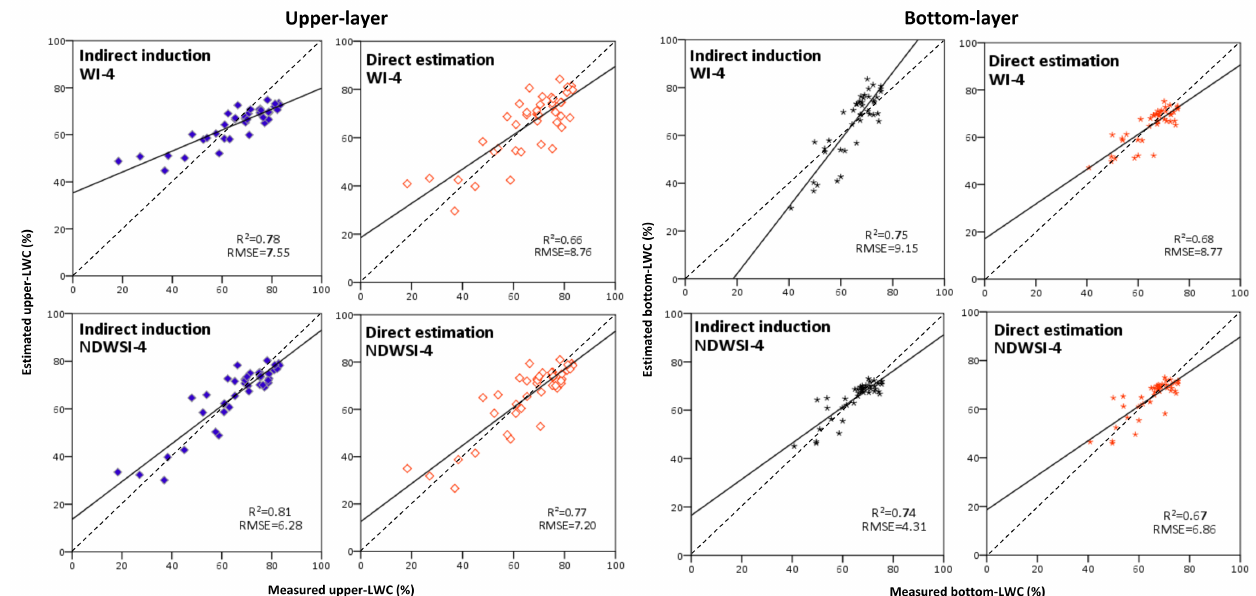
Figure 9. Comparison of validation models between measured LWC and estimated LWC in the upper-layer ( blue diamond and red diamond ) and bottom-layer ( black star and red star ) using the indirect induction and direct estimation methods. The four subplots in the first line are validation results based on the WI-4 for the upper- and bottom-layer, whereas the four subplots in the second line are validation results based on the NDWSI-4 for the upper- and